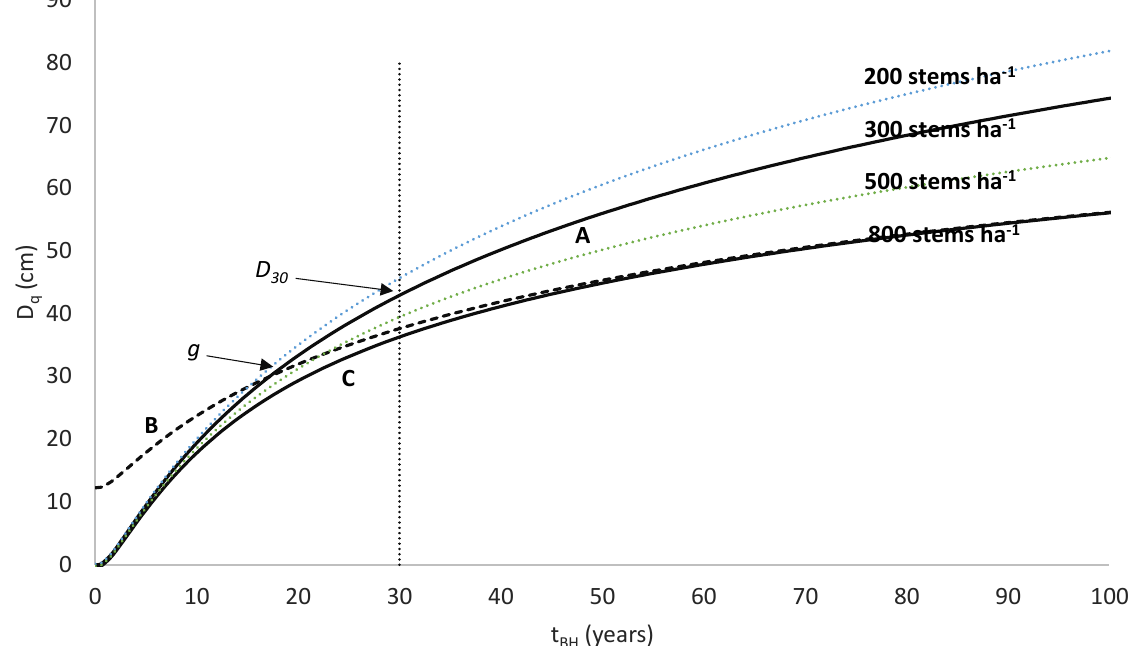
Figure 1. Geometry of Equation (2) showing D q predicted for stand densities of 200, 300, 500 and 800 stems ha − 1 . Line A is y = D ( t BH ), which is D q at a stand density of 300 stems ha − 1 . The dashed line B is y = kg + (1 − k ) D ( t BH ), where k = d ( ln 800 − ln 300), which intersects line A at y = g . The solid line C produced by a stand density of N = 800 stems ha − 1 initially follows line A but then transitions towards line